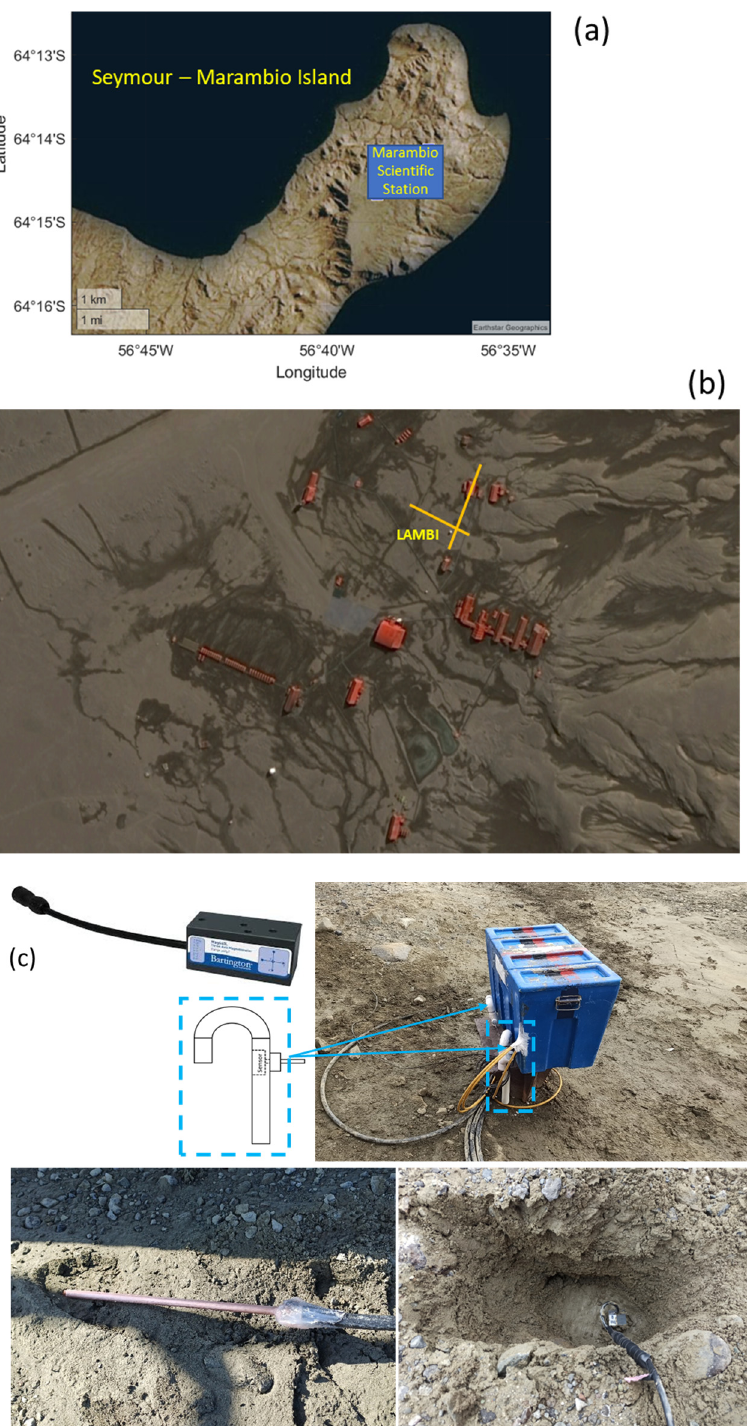
Figure 2. ( a ) MT deployment at the north Seymour–Marambio Island. ( b ) NNE (124 m) and EEN (80 m) are the two orthogonal dipoles’ locations. ( c ) Picture of the triaxial magnetometer Bartington Mag648L and the snorkel tube where CH 4 and CO 2 are sensed (upper left). The blue box contains the coupling and digital recording system (upper right). The four dipole electrodes were percussion buried 80 cm deep (lower images). The magnetometer and electrodes were buried in the permafrost.